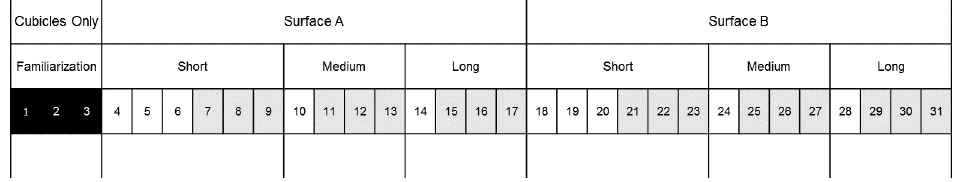
Fig 2. Representation for the 31-d study period, which was repeated 6 times using 5 cows per experimental period. Unshaded days represent training days and days shaded in gray represent choice periods. Days shaded in black represent the familiarization period, when cows did not have access to either open lying area. Short, Medium and Long describe the raceway distance in order to access the open lying areas, with Surface A being the first surface and Surface B being the second